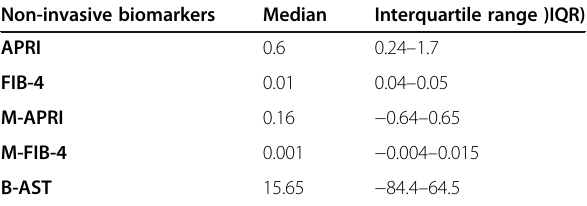
Table 3 Non-invasive biomarkers in the study